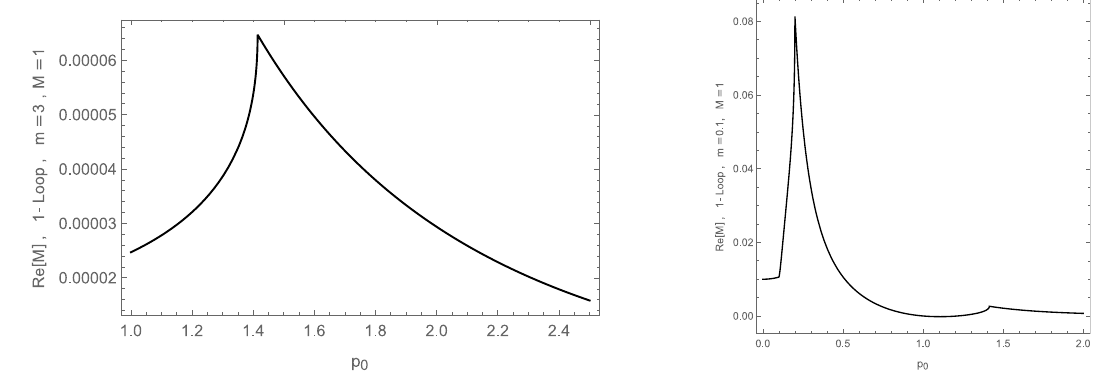
= k 0 (or k 0 = k 0 ) for 7 2 8 1 √ √ = 2 M = 2 . 0